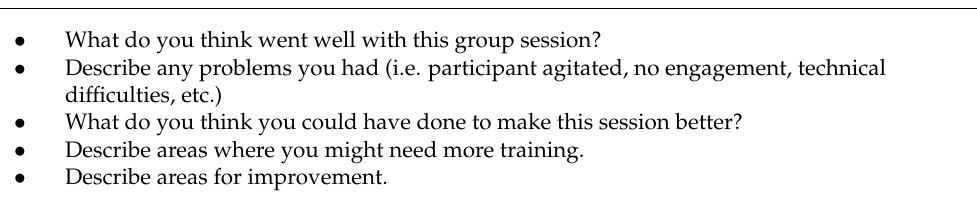
Table 4. Facilitator questions for reflection. Questions for Post-Session